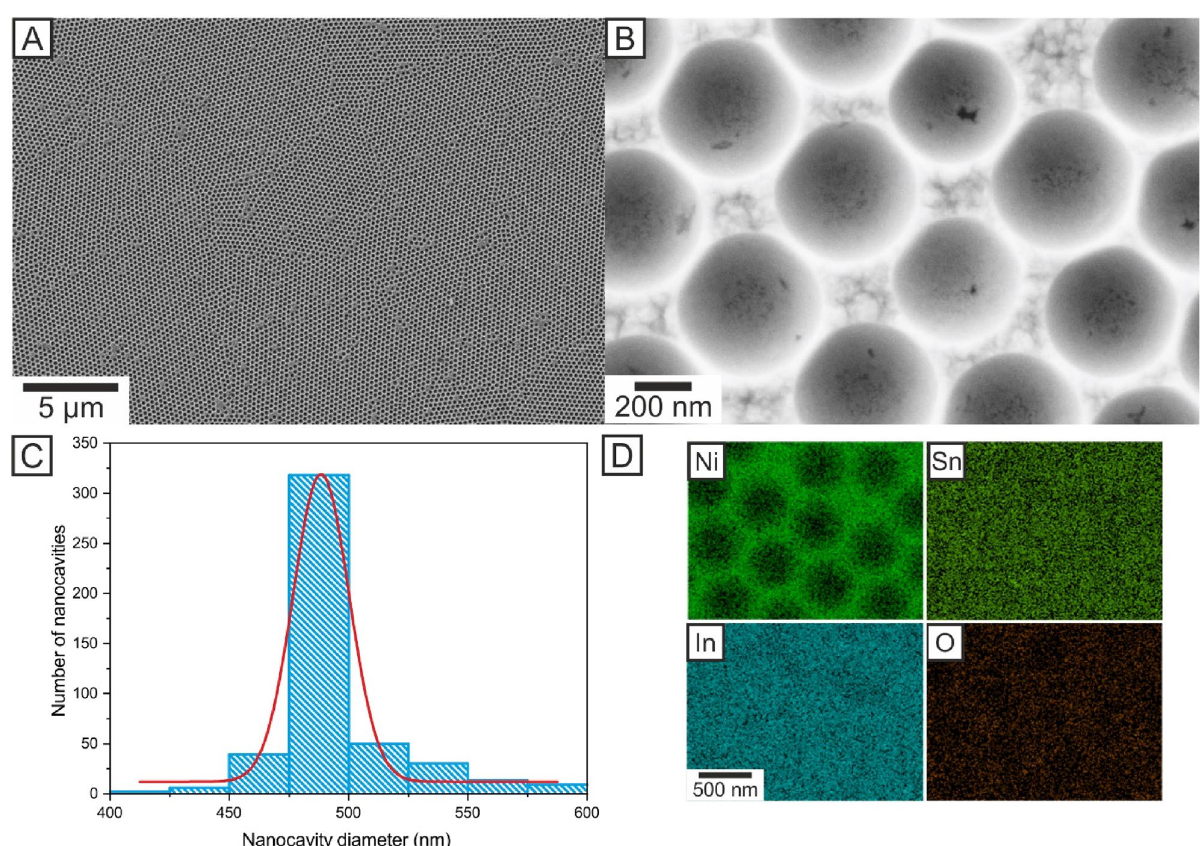
Figure 1. SEM images of the Ni nanocavity film at ×5000 magnification ( A ) ×150,000 magnification ( B ) with cavity size distribution ( C ) and EDX elemental distribution maps For Ni, Sn, In and O ( D